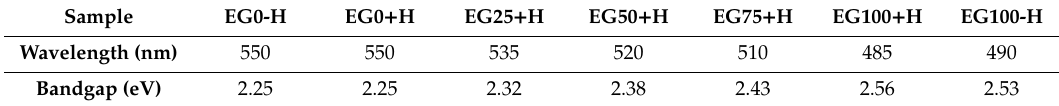
Figure 4. XRD patterns of the CdS nanocomposites. Table 2. Calculated bandgaps and corresponding wavelengths of various CdS samples.